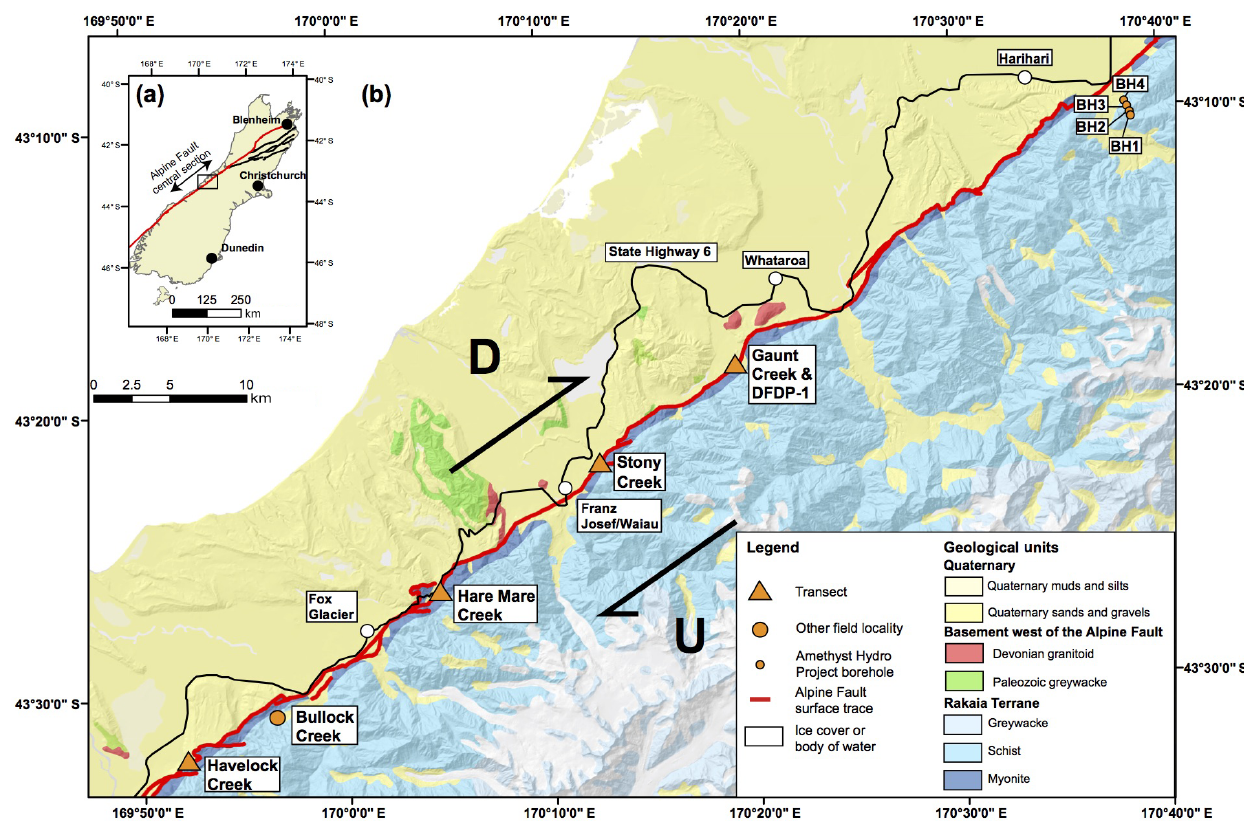
Figure 1. (a) Location map for Alpine Fault (red line) and Marlborough faults (black line) in the South Island of New Zealand. Box shows extent of (b) a location map for the first phase of the Deep Fault Drilling Project (DFDP-1) and Amethyst Hydro Project (AHP) boreholes, and field transects. The generalised underlying geology is derived from the GNS Science 1 : 250000 QMAP project (Rattenbury and Isaac, 2012) and has been draped over a digital elevation model (Columbus et al.,